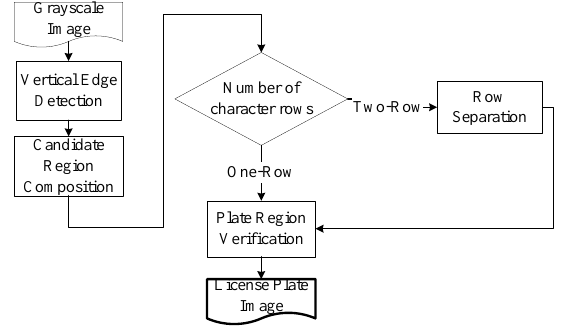
Figure 4: Process flow of license plate extraction In the Vertical Edge Detection step, vertical edges in the original image are detected by the Sobel edge detection algorithm. The next step is the Candidate Region Composition in which the edge points are merged into lines and then rectangles. They are considered as candidate regions that a license plate may exist. Finally in the Plate Region Verification step, various features of the candidate regions are examined and one of them is selected as the ultimate plate region and being further processed in the character segmentation phase. The mechanism is straightforward for one-row plates and one more step is needed for two- row plates, namely Row